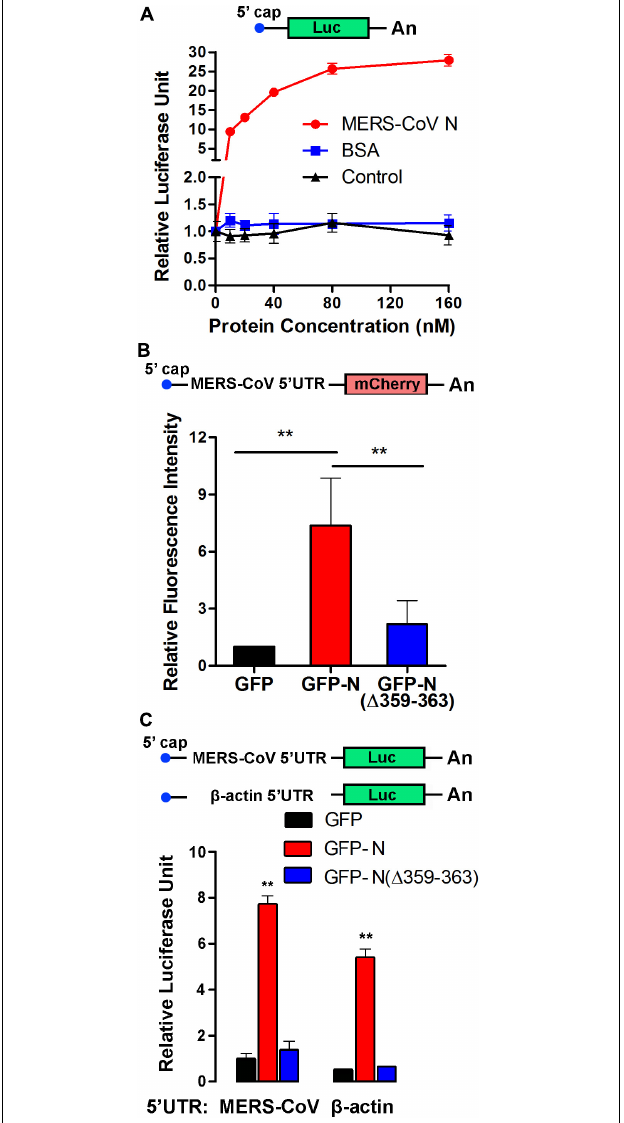
FIGURE 7 | The MERS-CoV N protein promotes protein synthesis. (A) An in vitro translation assay for luciferase-encoding mRNA was performed using rabbit reticulocyte lysate system. Different concentrations of purified MERS-CoV N protein, BSA, or negative control of purified N protein (equal volumes) were added to the preincubation mixtures. Luciferase activity was measured with a luminometer. (B) The 5 (cid:48) UTR sequence was synthesized according to the sg mRNAs of MERS-CoV and inserted upstream of an mCherry reporter gene driven by the T7 promoter. Capped and polyadenylated RNA transcripts were synthesized using an mMESSAGE mMACHINE T7 Ultra Kit. HEK293T cells were transfected with reporter RNA 12 h after being transfected with plasmids expressing GFP-MERS-CoV N, GFP-MERS-CoV N( (cid:49) 359–363), or GFP. The level of mCherry expression was detected 30 h later using a multilabel plate reader. The data are presented as the mean ± SD of three independent experiments. ** P < 0.01 by unpaired two-tailed Student’s t -test. (C) The 5 (cid:48) UTR sequence was synthesized according to the sg mRNAs of MERS-CoV or the mRNA of β -actin and inserted upstream of a luciferase reporter gene driven by the T7 promoter. The cell transfection details and experimental statistics are the same as in panel (B)